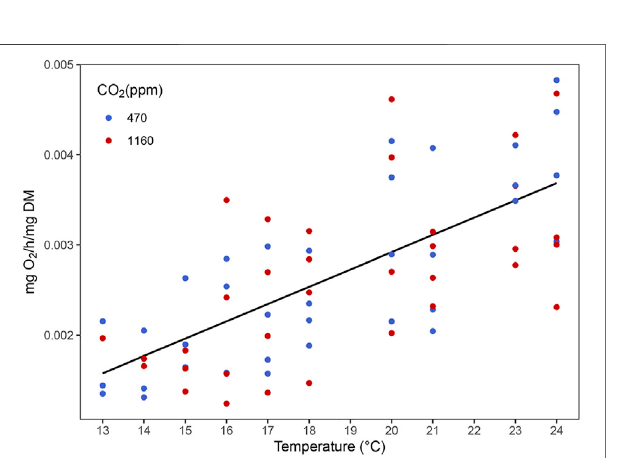
Frontiers in Physiology |